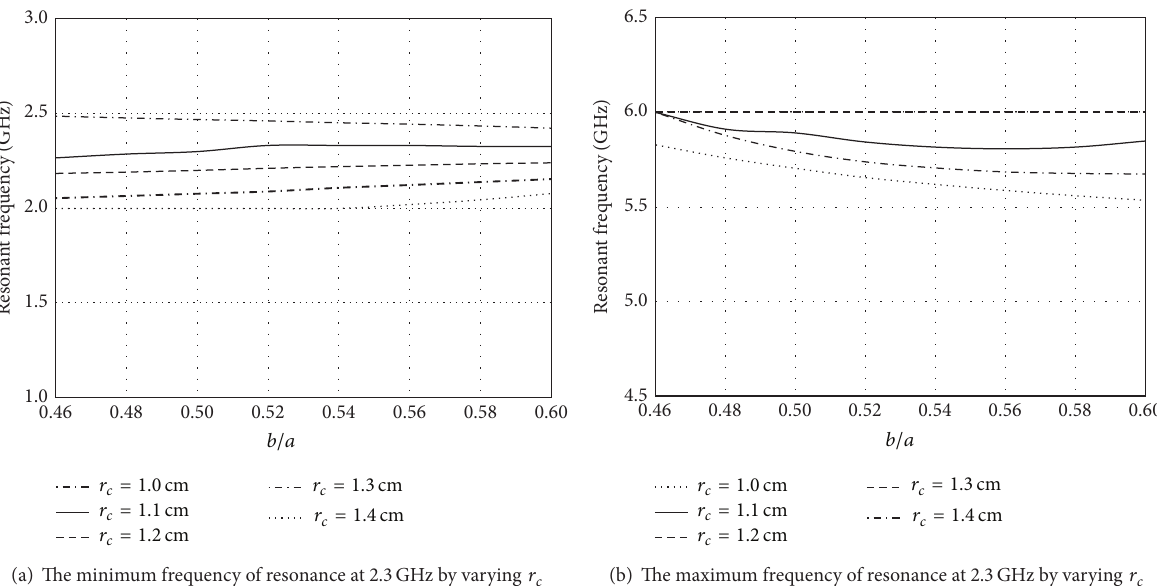
Figure 4: The resonant frequency relative to 𝑏/𝑎 for various 𝑟 𝑐 ( 𝑎 = 7.20 cm, 𝑑 = 2.60 cm, and ℎ = 2.40 cm).